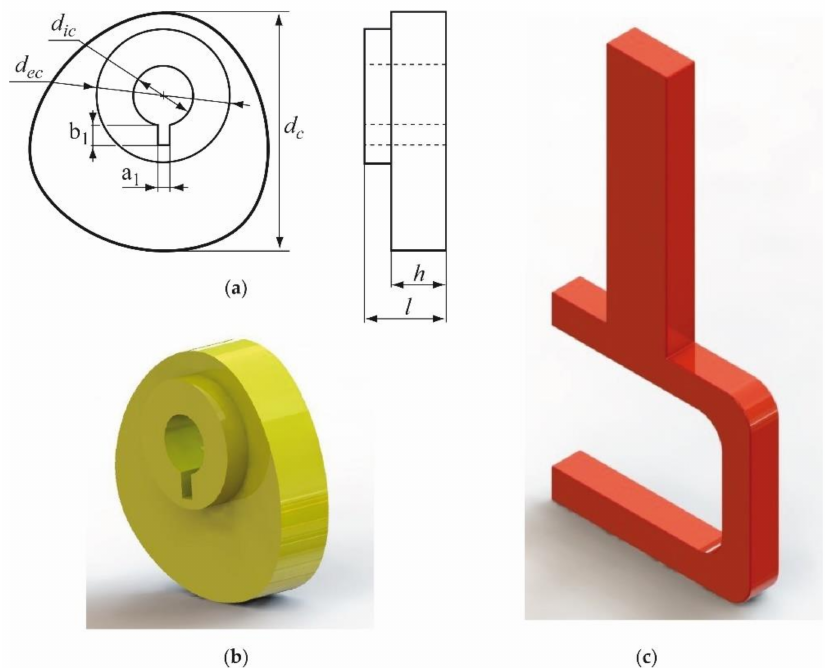
Figure 8. ( a ) Main dimensions of the hub and keyway of the cam, and virtual models of the ( b ) constant-breadth cam and ( c ) the double flat-faced follower.